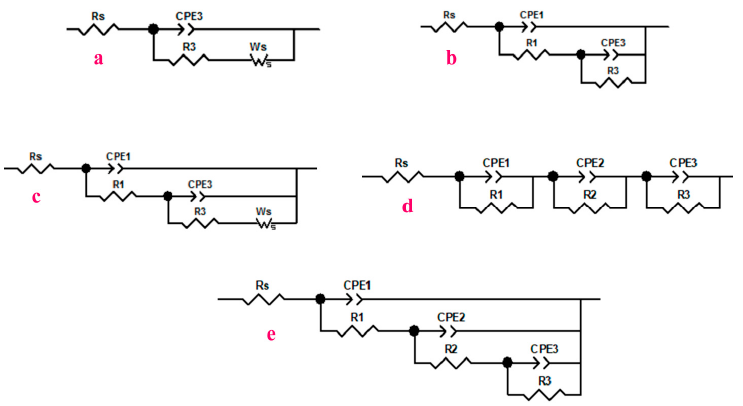
Figure 5. Equivalent circuits for EIS results for the bare and as-prepared hydrophobic surfaces of SS AISI 410S samples. ( a ) Randles EEC, bare surface SS AISI 410S after 1 h and 10 h of immersion ( b ) bare surface SS AISI 410S after 25 h and120 h of immersion and as-prepared hydrophobic surfaces (SA) after 10 h, 25 h and 120 h of immersion ( c ) as-prepared hydrophobic surfaces (SA) after 1h of immersion( d ) as-prepared hydrophobic surfaces (SA + 0.5% E307) and (SA + 1.0% E307) after 1h- 120h of immersion and also (SA + 2.0% E307) after 120 h of immersion ( e ) as-prepared hydrophobic surfaces (SA + 2.0% E307) after 1h-25h of